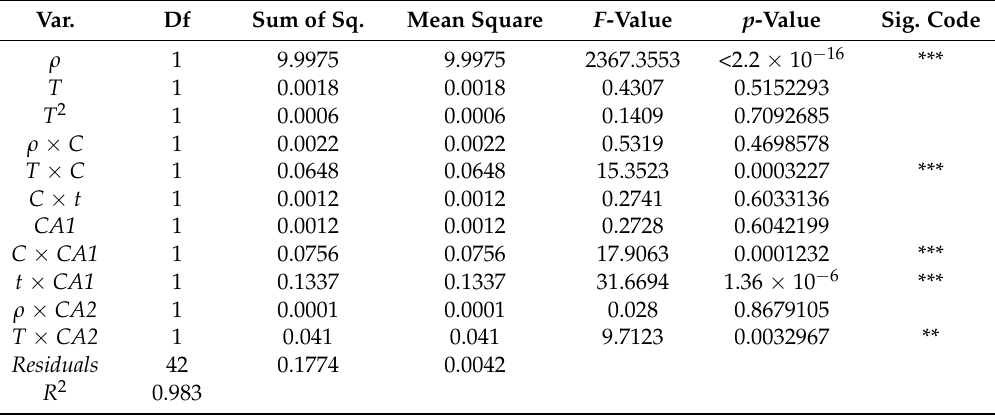
Table 3. ANOVA table for the “ W ” quadratic